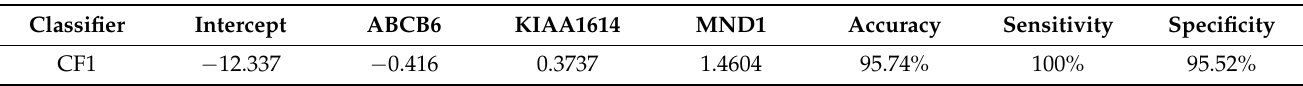
Table 11. GSE163151: Characteristics of the top-performing three-gene classifier CF1 for data of whole blood vs. NP/OP swabs.